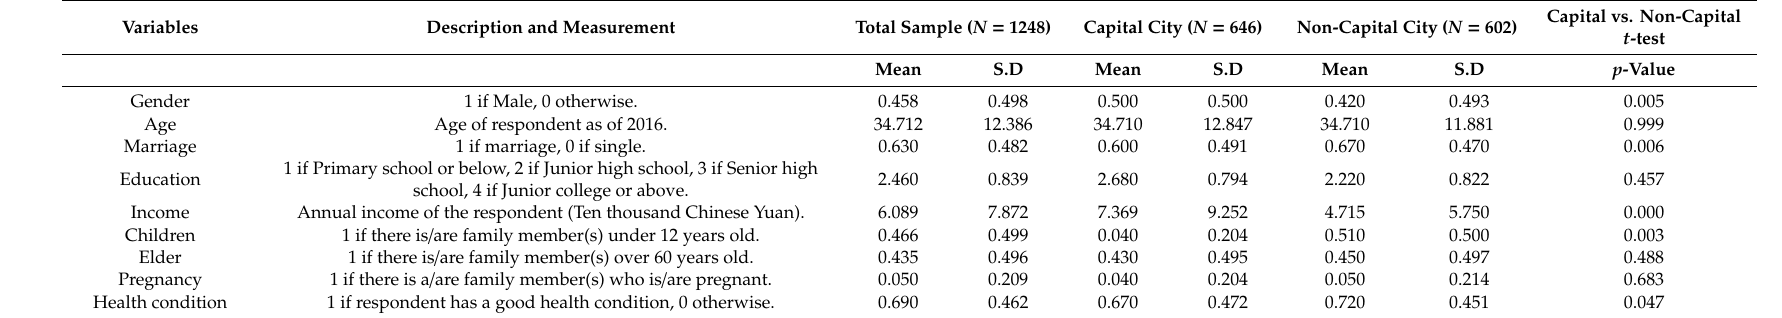
Table 2. Description of social-demographic